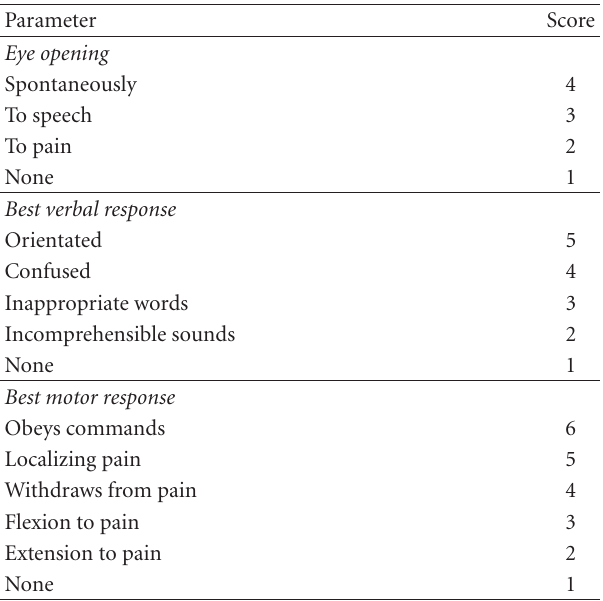
Table 1: Glasgow Coma